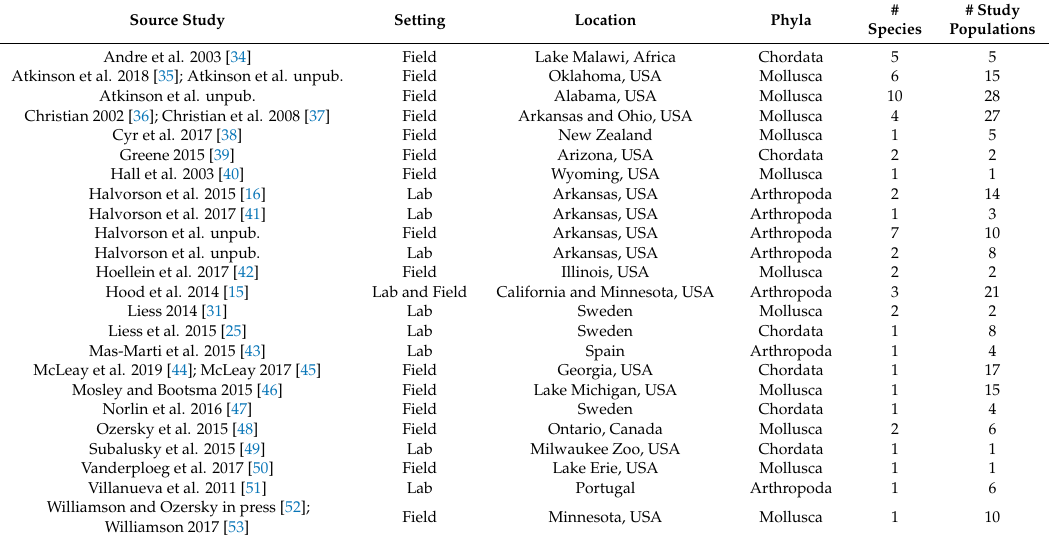
Table 1. Summary of datasets included in the meta-analysis of egestion and excretion rates across freshwater animal taxa. See Supplementary Material 1 for a comprehensive summary of release ratios and relative variance across all study